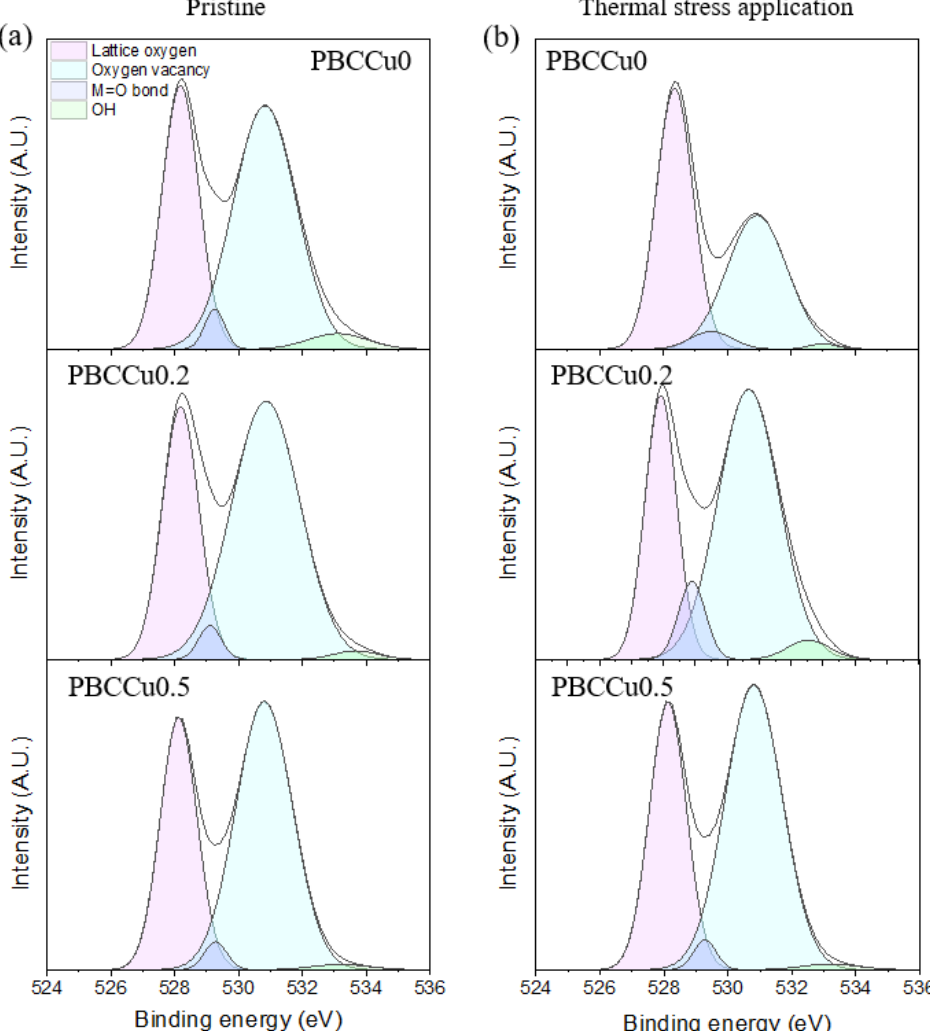
Figure 4. O 1 s core level spectra (black solid line) together with the fit results (colored area) for PBCCu x : ( a ) Pristine and ( b ) After applying thermal stress for 100 h on 1050 °C.